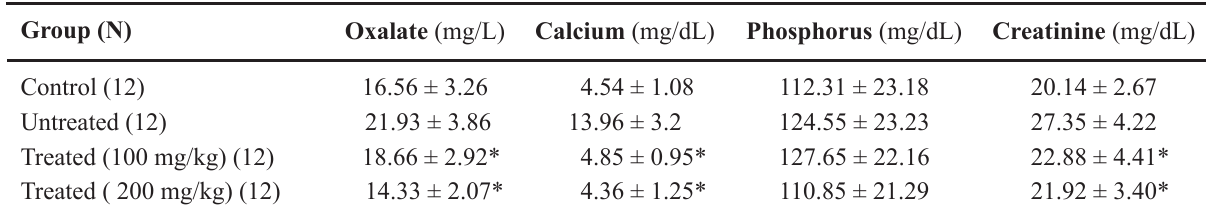
Table 2 – Effect of aqueous extracts of Rubus idaeus on some serum parameters in control and glyoxylate-treated ani- mals.